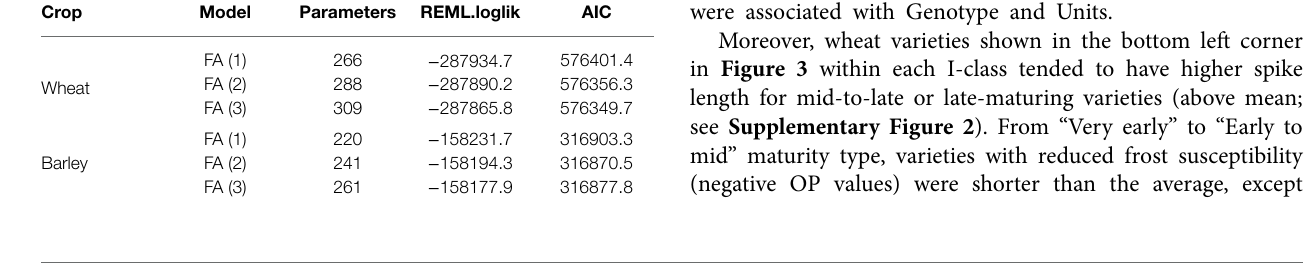
TABLE 6 | Rotated REML estimates of loadings from the FA (3) model for genotype by environment interactions effects. Missing values correspond to zero genetic variance or when the FEE was not sown (e.g., sa10 and sa11 in barley). There were differences in the frequency distribution of I-classes across states (see last column below and Supplementary Figure 1 ).